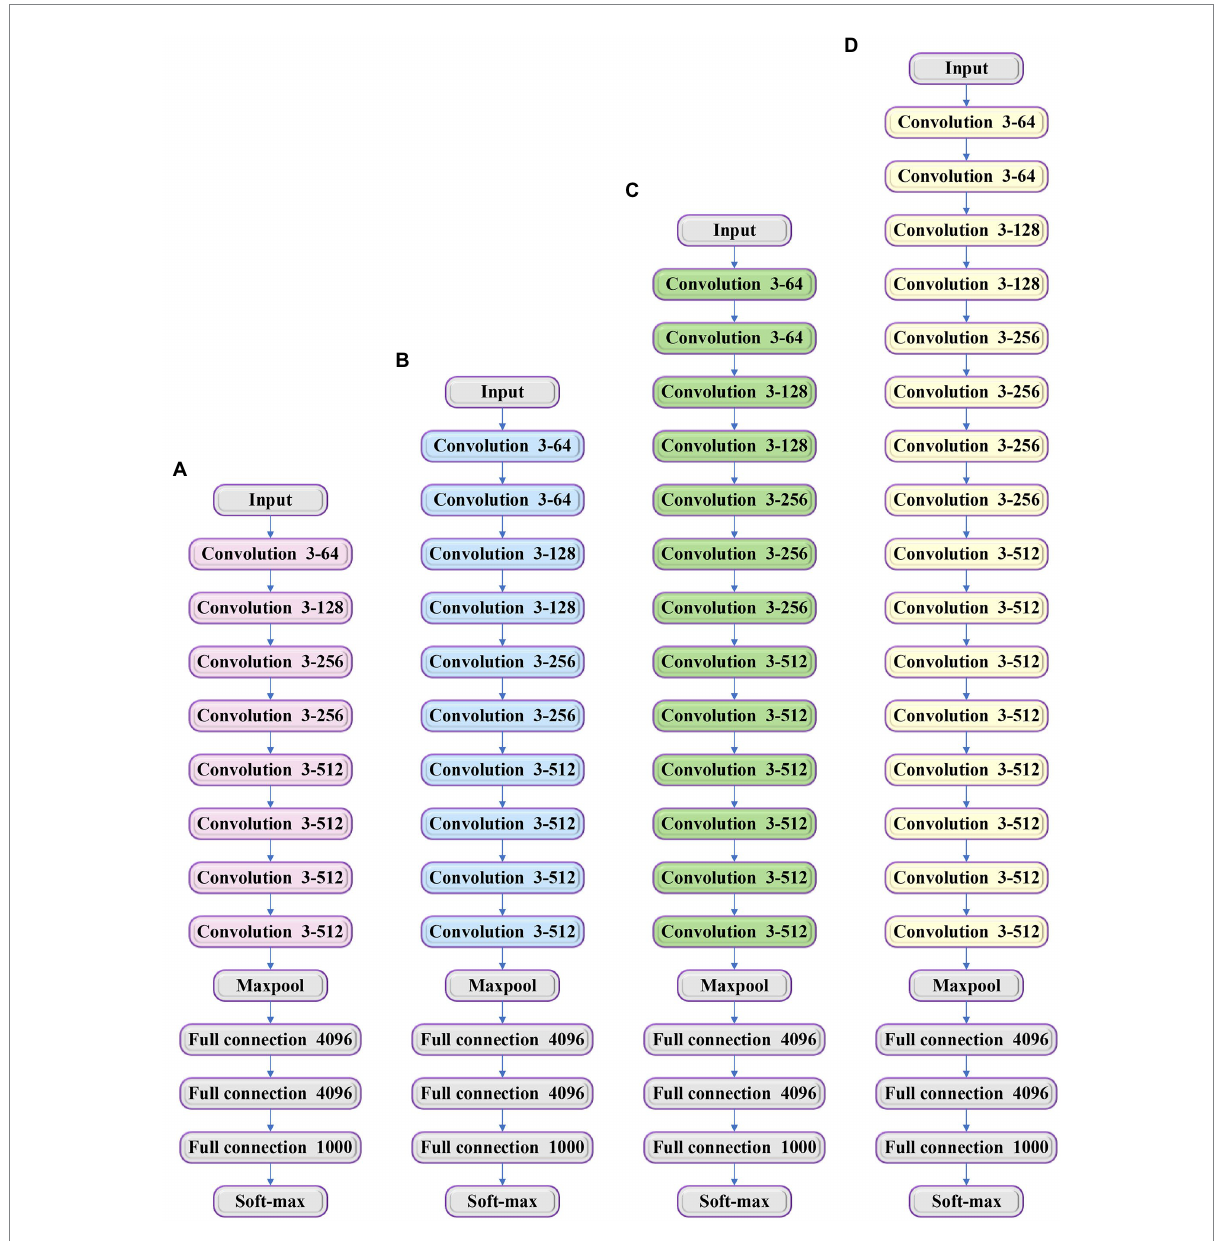
FIGURE 4 Structure of different types of visual geometry group (VGG; A ) VGG-11; (B) VGG-13; (C) VGG-16; and (D)